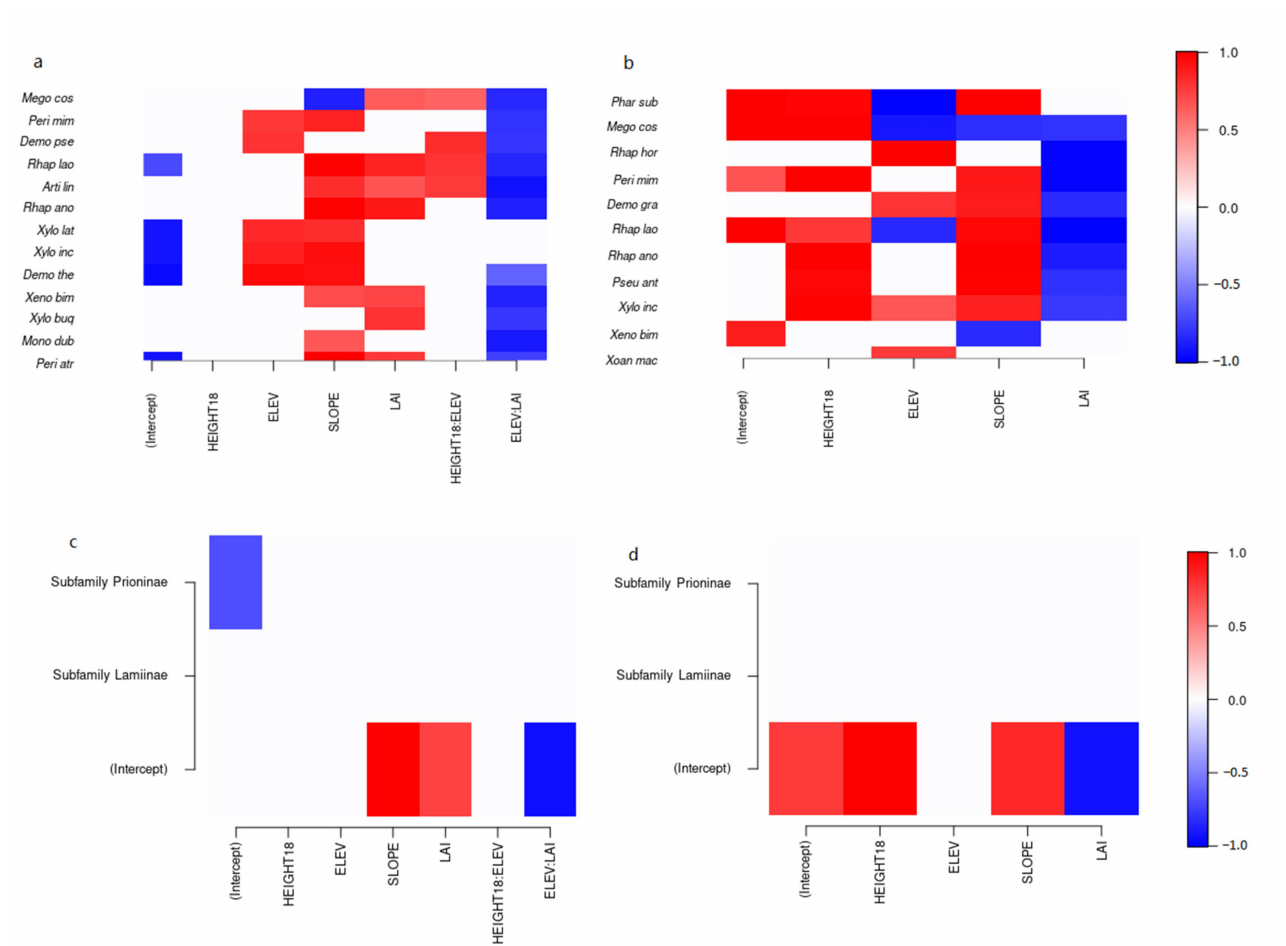
Figure 2. Heatmap illustrating the support (>0.80) for positive or negative β -coefficients across species ( y -axis) and environmental factors ( x -axis) ( a , b ) and for γ -coefficients across cerambycid subfamilies ( c , d ) (Cerambycinae was the baseline group and hence represents the intercept, while Prioninae was represented by a single species, Megopis costipennis ); ( a , c ) Incidence model (Probit); ( b , d ) Abundance model (Lognormal Poisson). Red indicates a positive coefficient, while blue indicates a negative coefficient. Models were estimated using Hierarchical Modeling of Species Communities (HMSC; [39]). Only those species for which the predictive Tjur r 2 or r 2 , respectively, based on a 5-fold cross-validation, was >0.10 have been